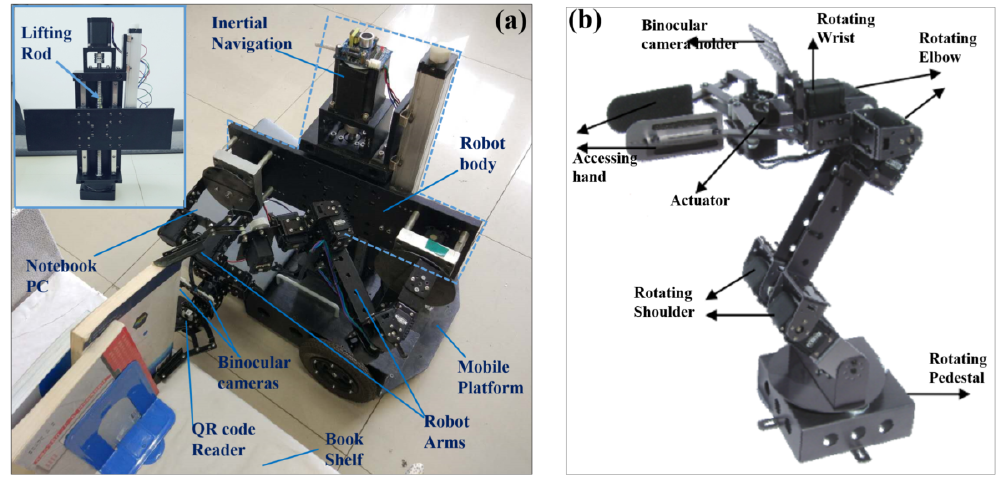
Figure 1. Structure design of the library mobile robot for book accessing and returning (BAR) operations. ( a ) The overall library robot structure. Inset: The robot body with a lifting rod fixed on it; ( b ) The robotic arm structure design for BAR